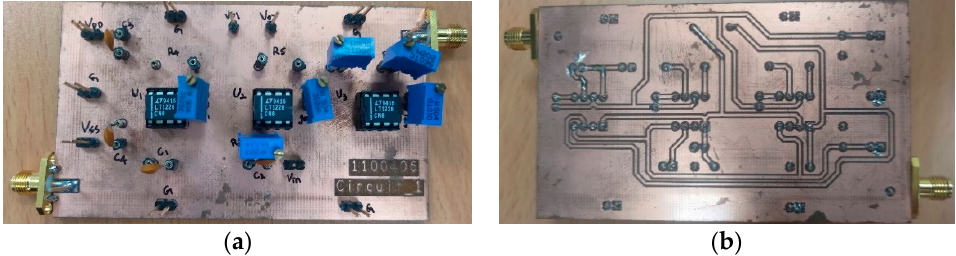
Figure 4. The ( a ) top view and ( b ) bottom view of the measured prototype from Figure 2.